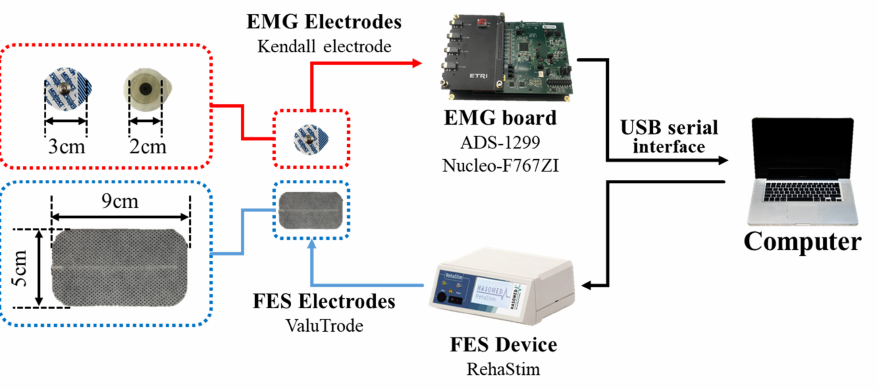
Figure 3. Schematic of experimental